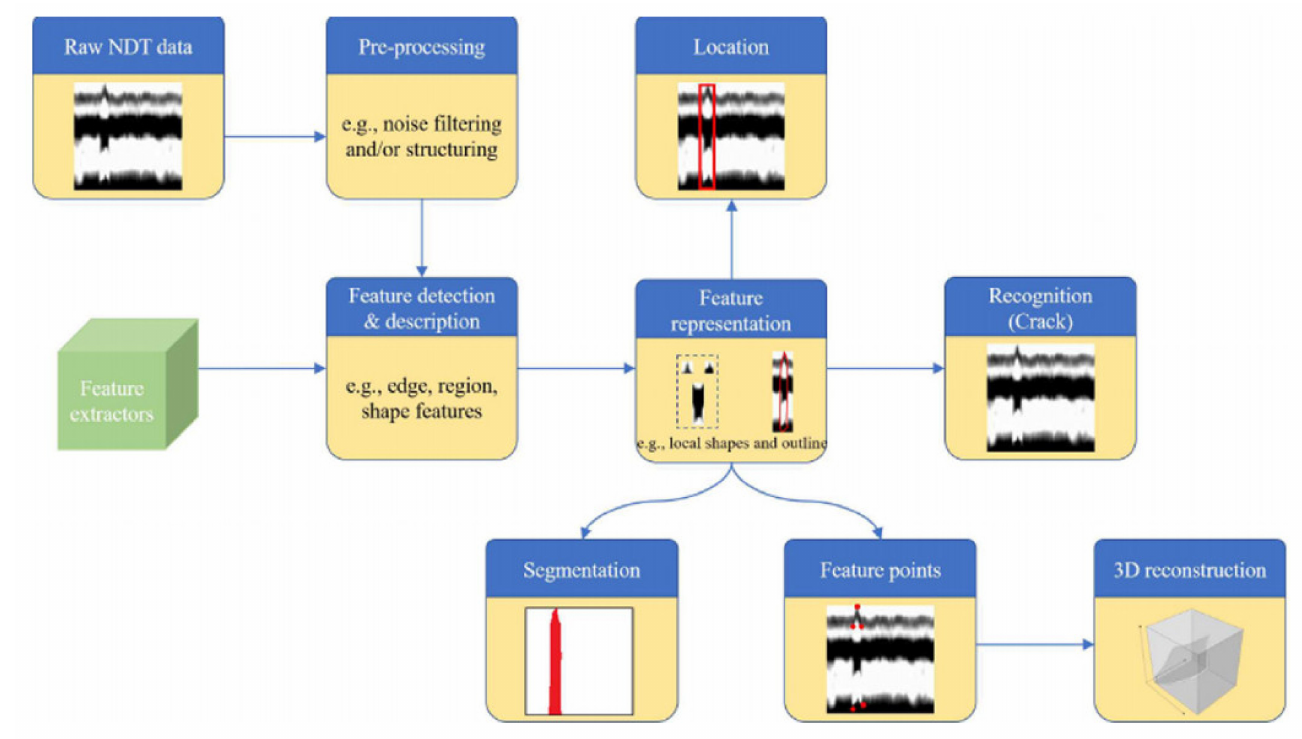
Figure 14. Generic pipeline for processing a group of GPR data